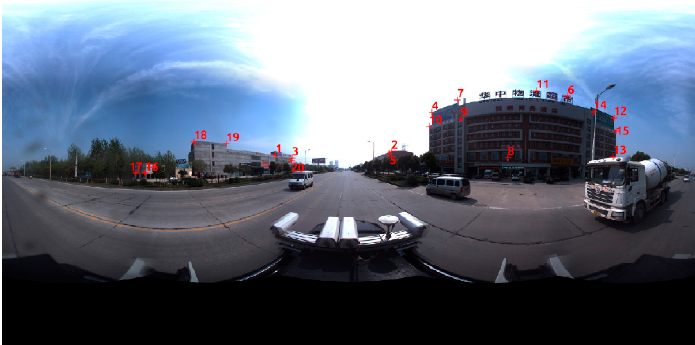
Figure 12. Check points distribution shown on panoramic image. (The meaning of the Chinese characters on the building is Supermarket for Logistics in Central China).